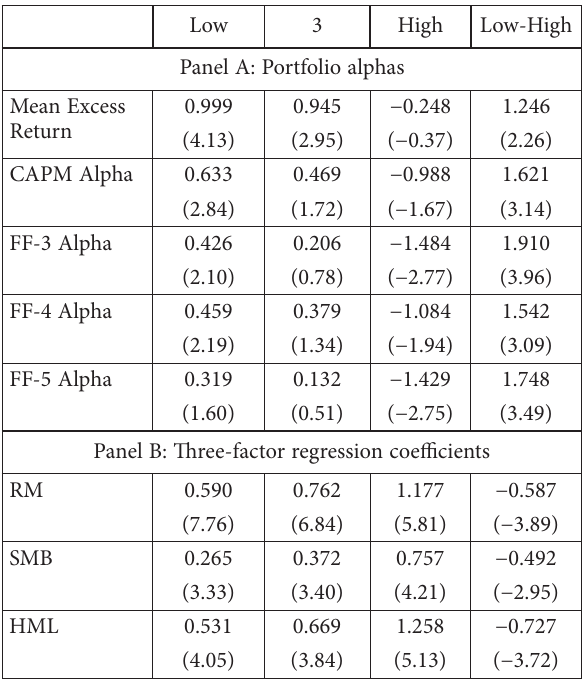
Table 2. Returns on default risk sorted REIT portfolios